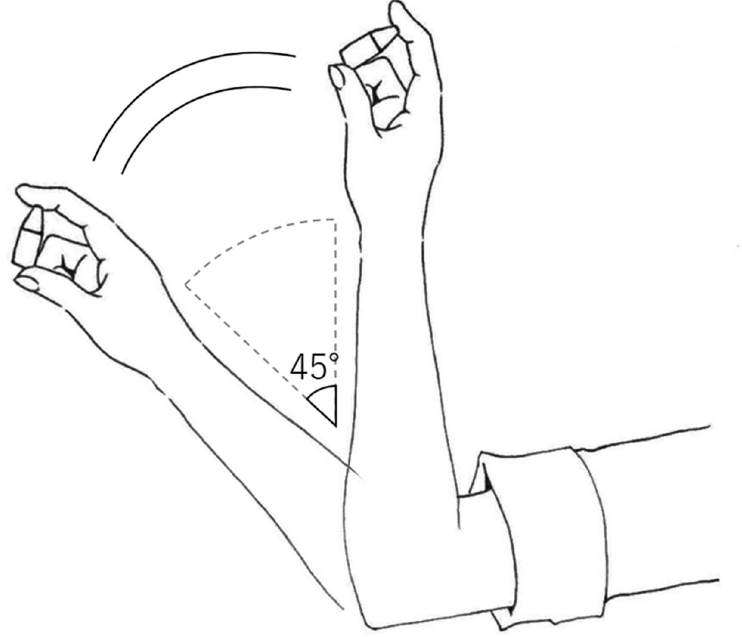
Fig 1. The method used for agitation with hands. Each bottle of 0.1% FLU ophthalmic suspension was held between the thumb and index finger at a standing position, and subsequently, the elbow was placed on the table. Subsequently, each bottle was shaken at a given angle ranging from 45–90 degrees every second, approximately 10